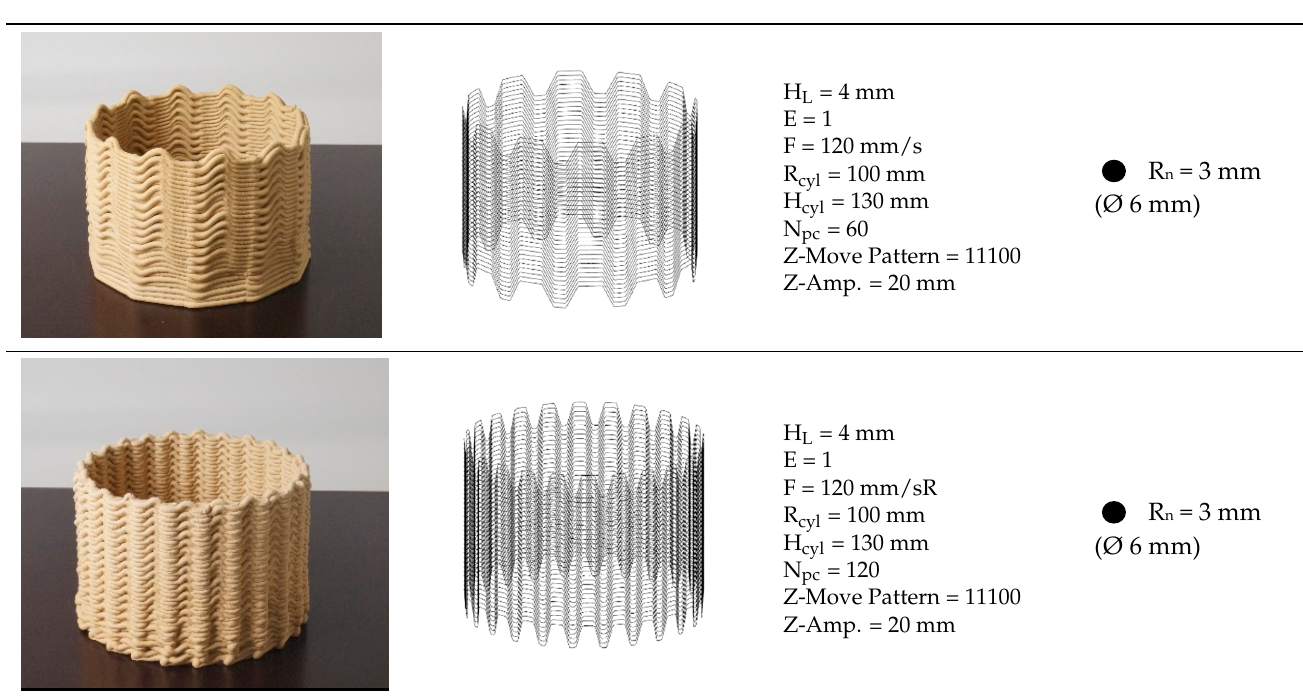
Table 1. Comparison of Grasshopper modelling during path instruction and materialized implementation in the LDM of clay with machine and software parameters.